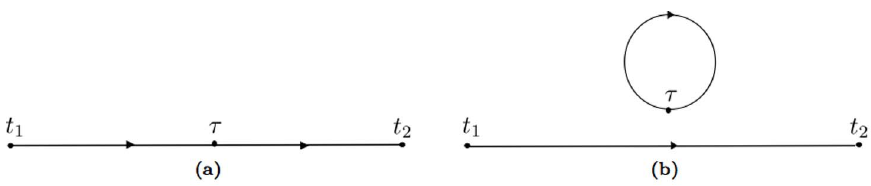
Figure 7. The graphical representation for the expressions (59) and (60).